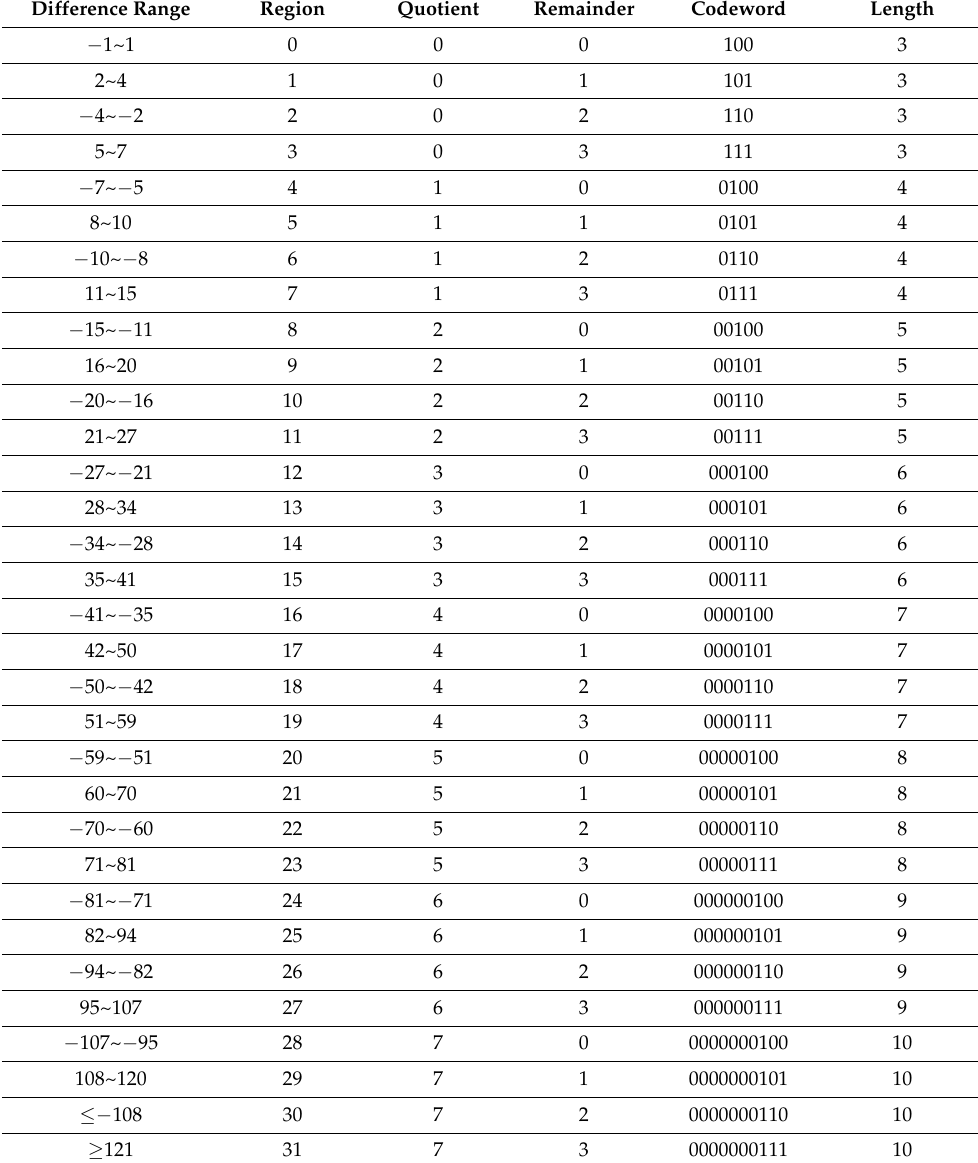
Table 3. Golomb–Rice coding table used in this